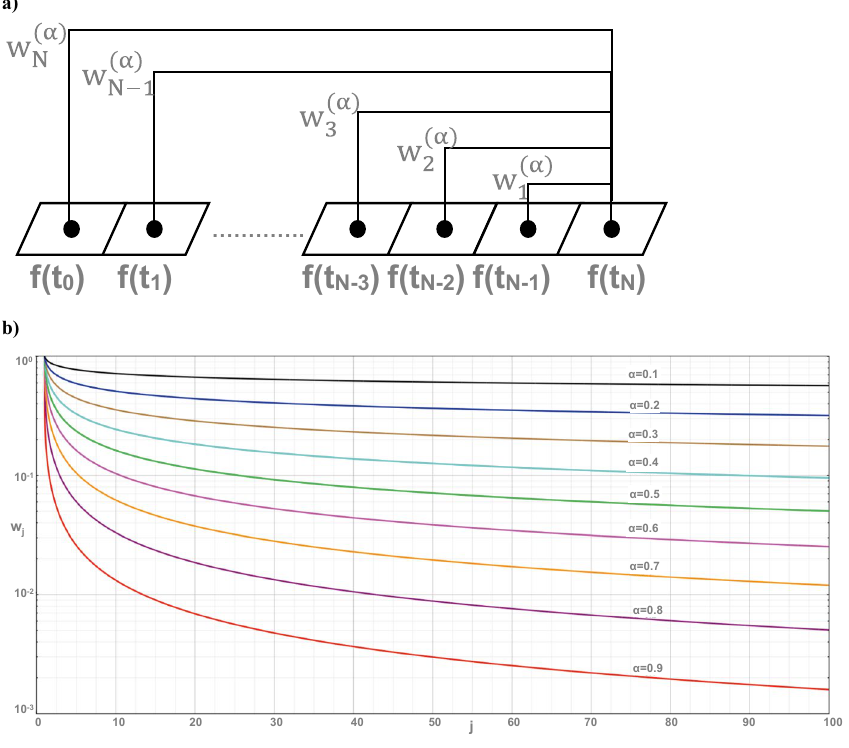
(α) j (for j = 1, 2, …, N) in estimating the fractional derivative